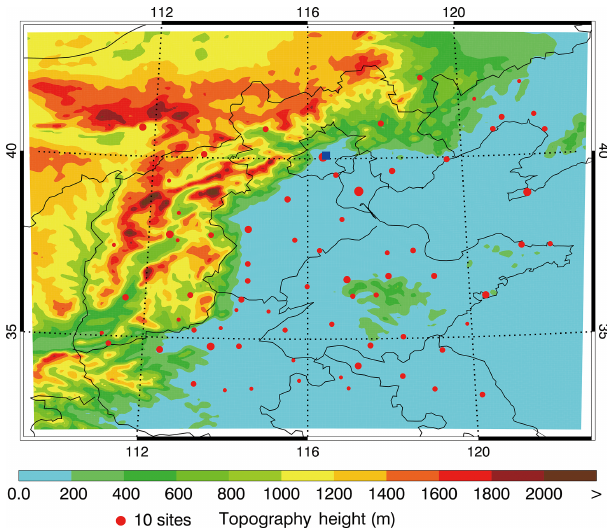
Figure 1. WRF-Chem simulation domain with topography. The red filled circles show the locations of the cities with ambient air quality monitoring sites, and the size of the circles represents the number of sites in each city. The blue filled rectangle denotes the CRAES observation site in